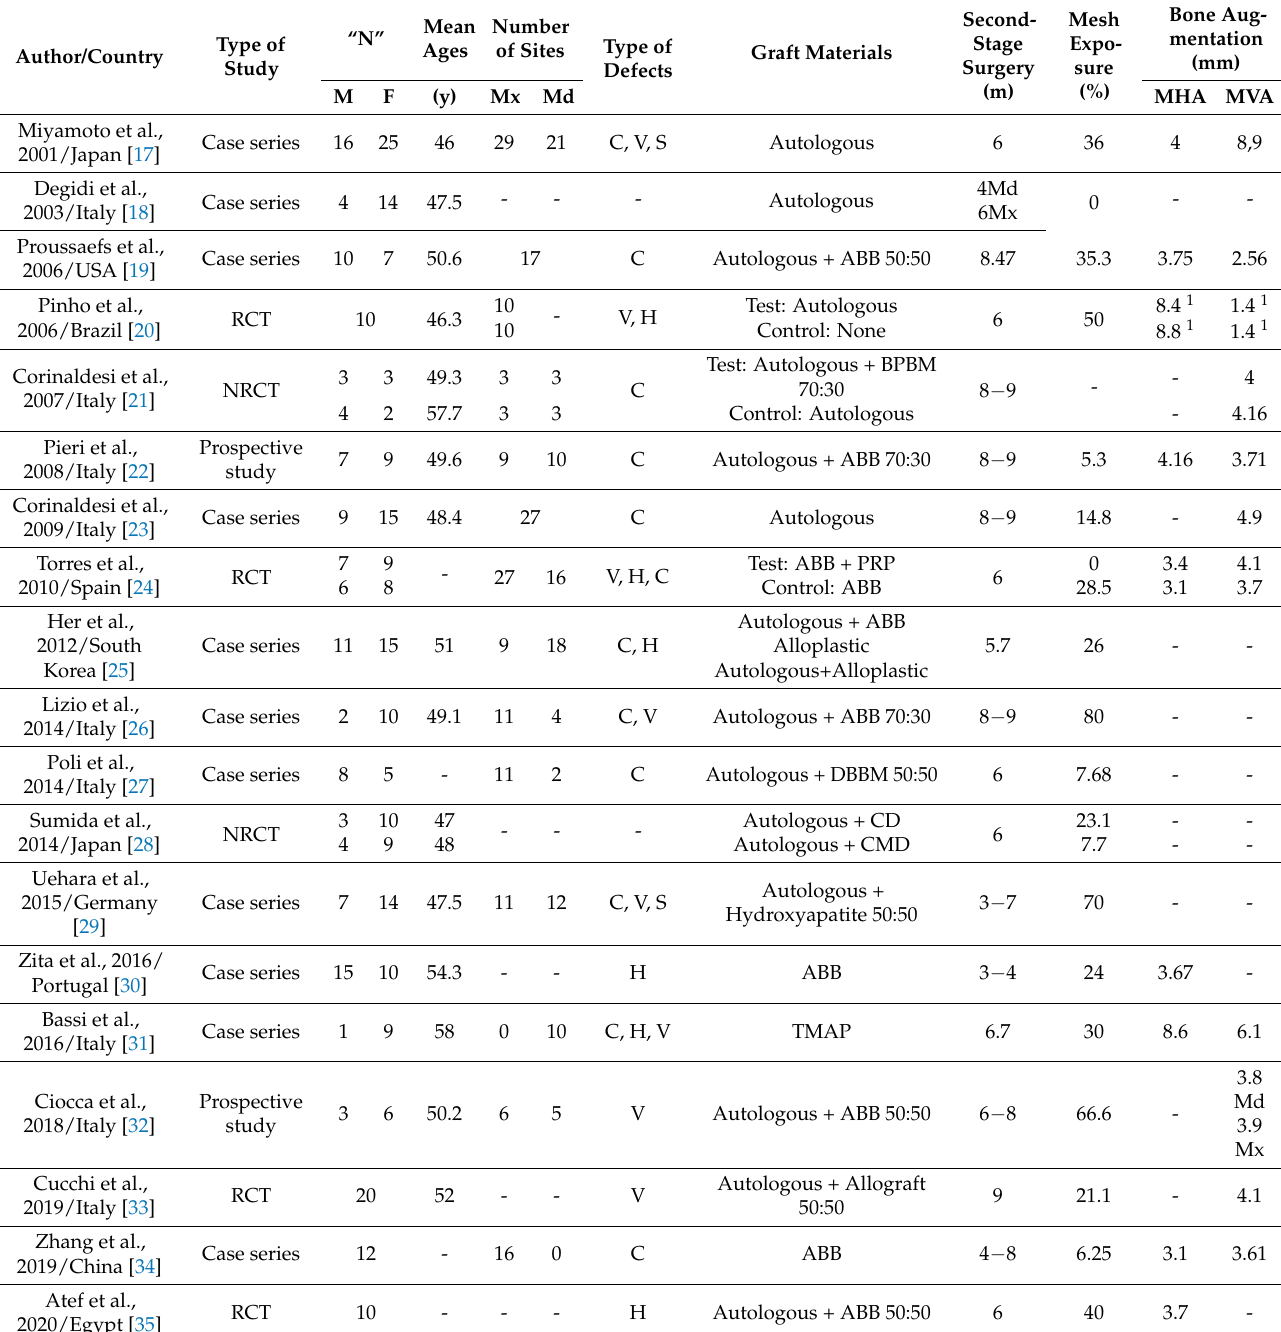
Table 1. Characteristics of the included